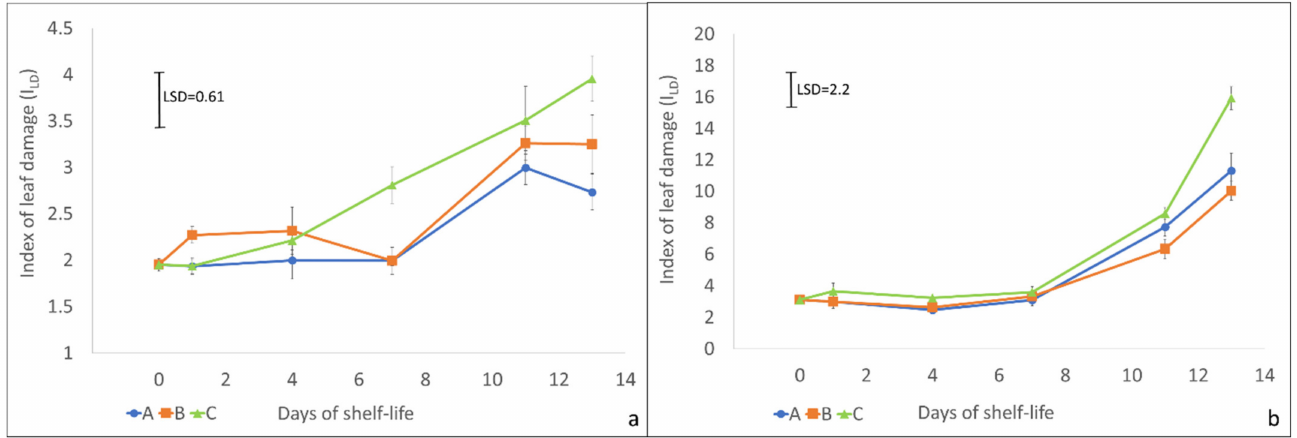
Figure 3. Index of leaf damage (I LD ) of rocket salad samples of trial 1 ( a ) and 2 ( b ) ± standard error. The result of the LSD post-hoc test is reported in each graph ( p <